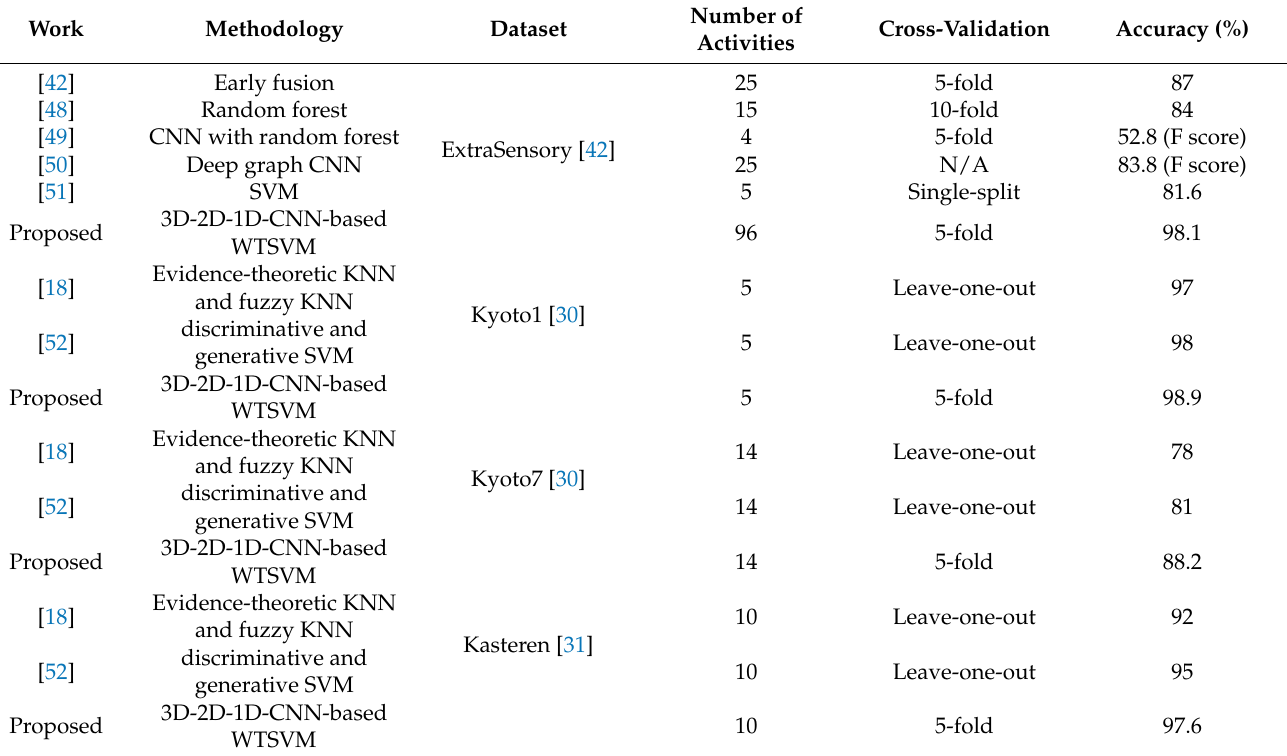
Table 6. Comparisons between existing works and our